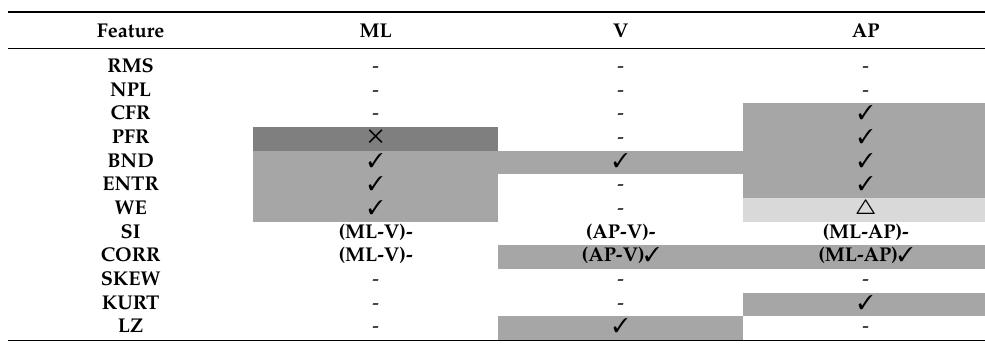
Table 3. Summary of significant features from the generalized linear regression model. - (white) Indicates no significant differences. (cid:52) (light gray) Indicates that the three conditions were not all equal. (cid:51) (medium gray) Indicates that the PRE condition was different from the COG condition. (cid:53) (dark gray) Indicates that the PRE condition was different from the POST